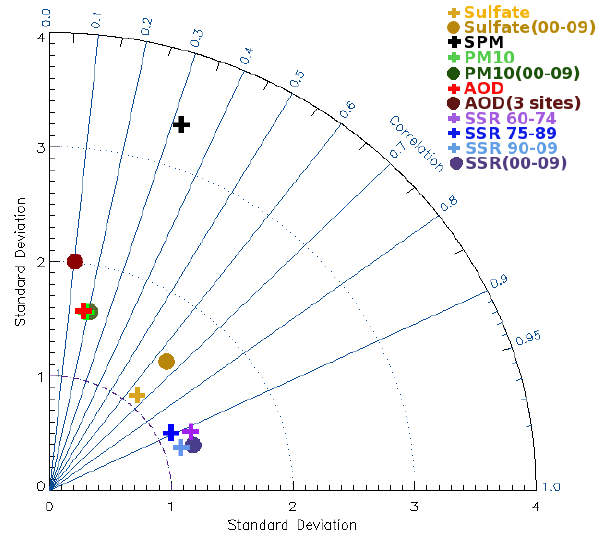
Figure 15. Taylor diagram comparing simulated and observed Eu- ropean sulfate mass concentrations, SPM, PM 10 , AOD and SSR. Comparisons are made across all the years where observations are available. We additionally show results for the period 2000–2009, where sulfate, PM 10 , AOD and SSR are consistently available. For AOD, we separately plot the three locations with the longest obser- vational record. For SSR we also plot the three different time peri- ods (1960–1974, 1975–1989, 1990–2009). Correlation coefficients are plotted against the observed standard deviations normalised rel- ative to the simulated standard